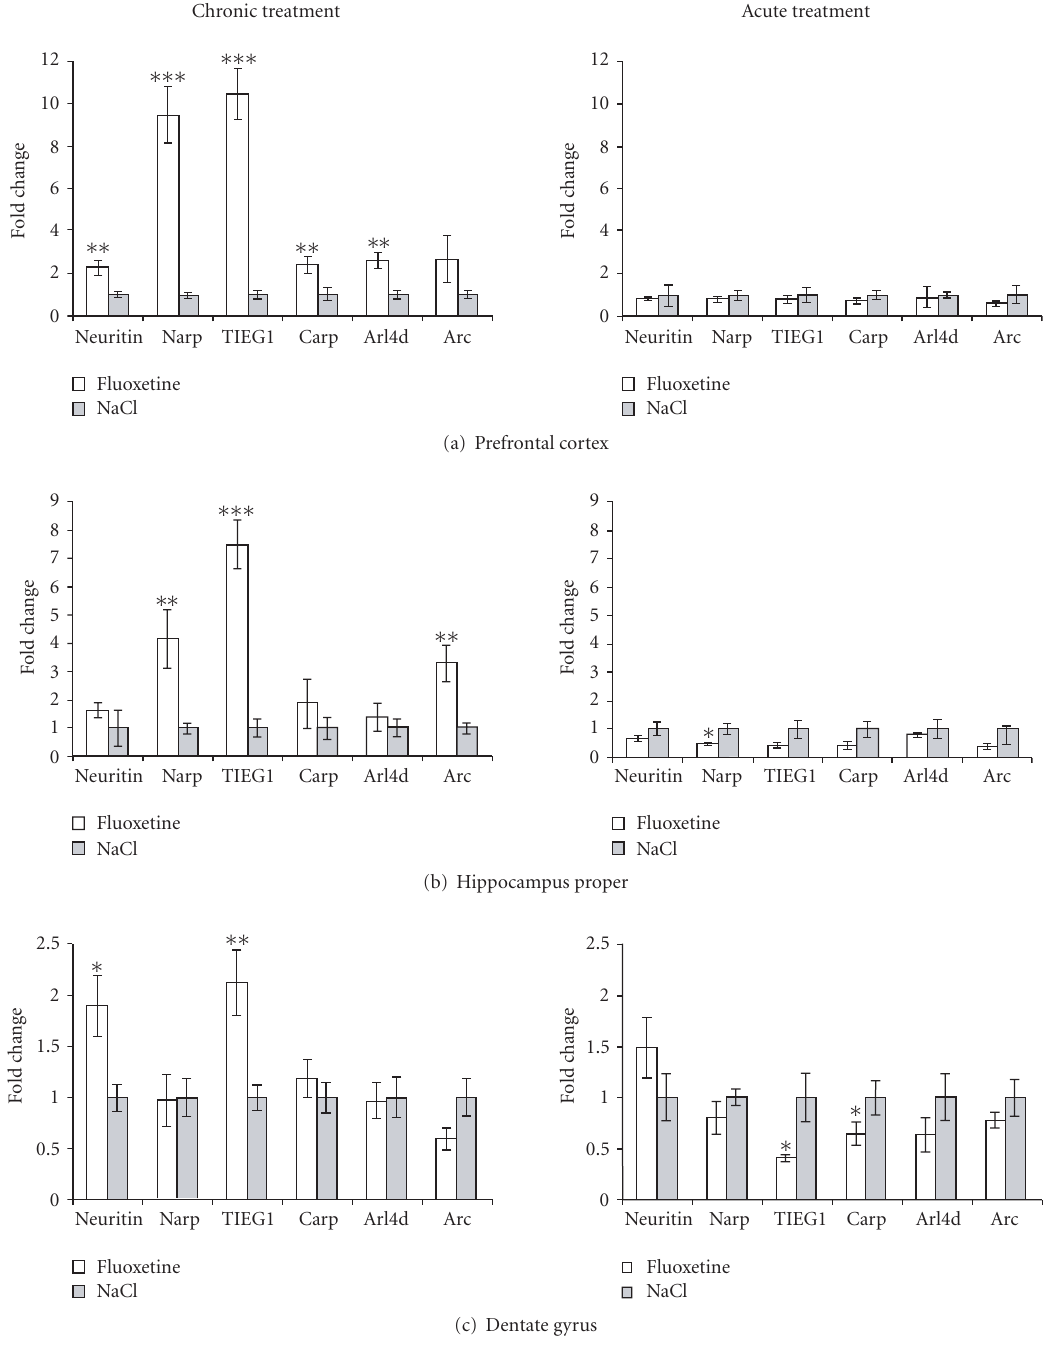
Figure 1: Chronic fluoxetine administration leads to brain region-specific upregulation of LTP-associated genes. Changes in mRNA expres- sion following fluoxetine treatment are expressed as fold change relative to the saline control group. (a) Prefrontal cortex, (b) hippocampus proper, (c) dentate gyrus. N = 7 fluoxetine chronic, n = 8 NaCl chronic, n = 5 fluoxetine acute, n = 4 NaCl acute (except neuritin chronic NaCl in DG, n = 7). ∗ P < . 05, ∗∗ P < . 01, ∗∗∗ P < . 001 from Student’s t